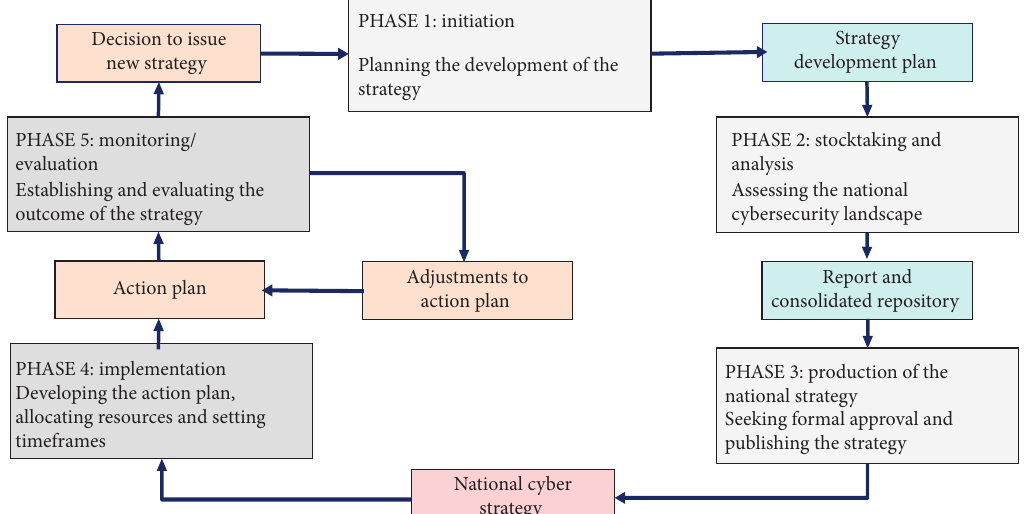
Figure 8: ITU NCSS lifecycle [46].